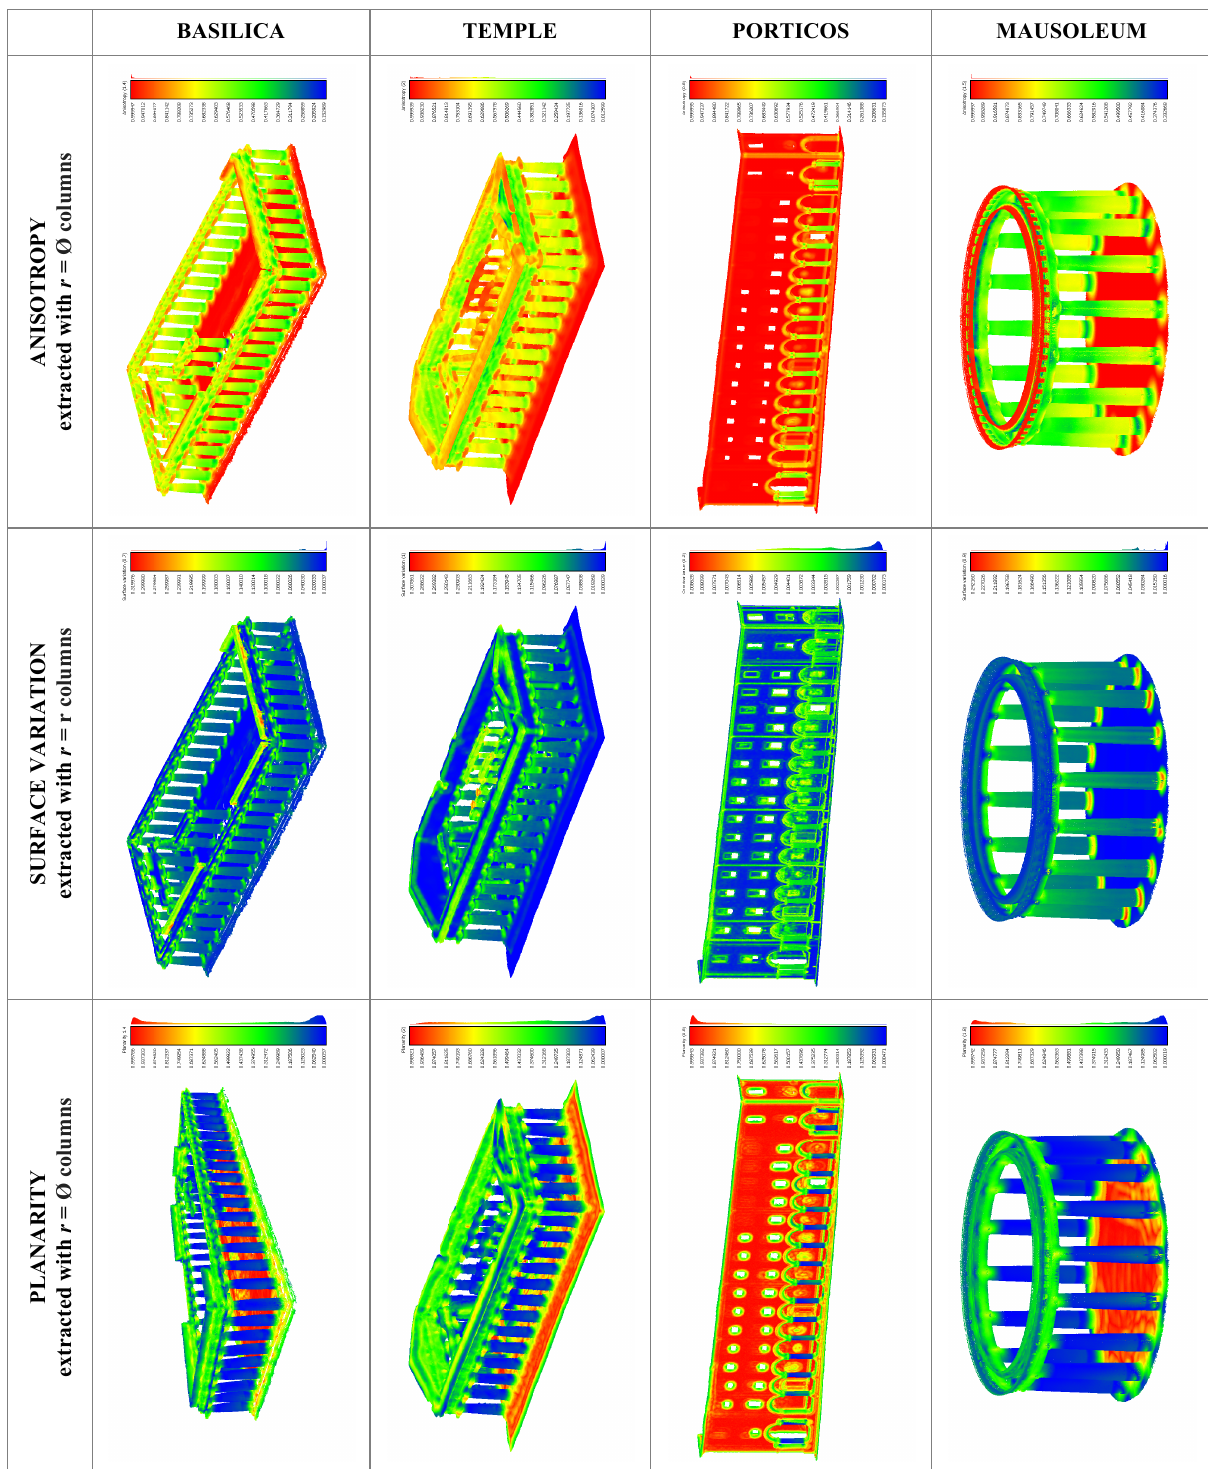
Table 6. Visual comparison of some geometric features extracted ad hoc on the different case